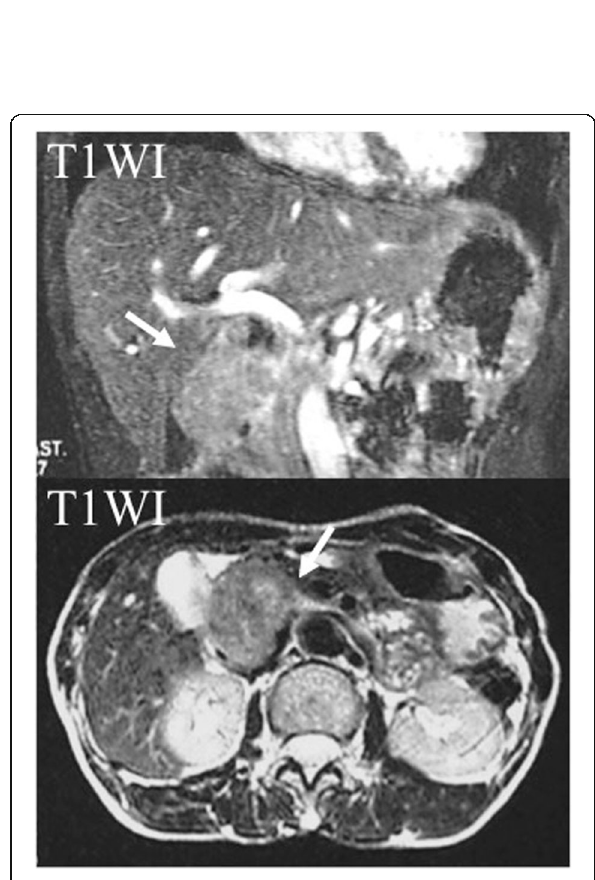
Fig. 2 Abdominal magnetic resonance imaging. The arrow indicates the tumor. Magnetic resonance imaging shows a well-defined lesion along the course of the IVC. IVC inferior vena cava